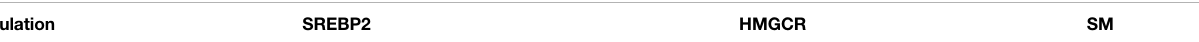
TABLE 1 | Molecules implicated in SREBP2, HMGCR, and SM regulation.